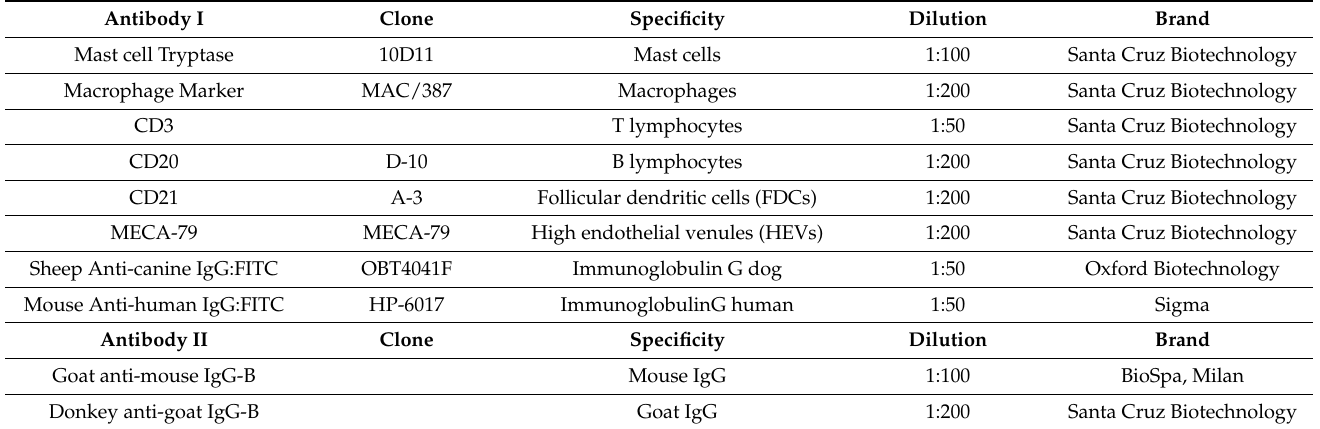
Table 2. Primary and secondary antibodies used for HIC and